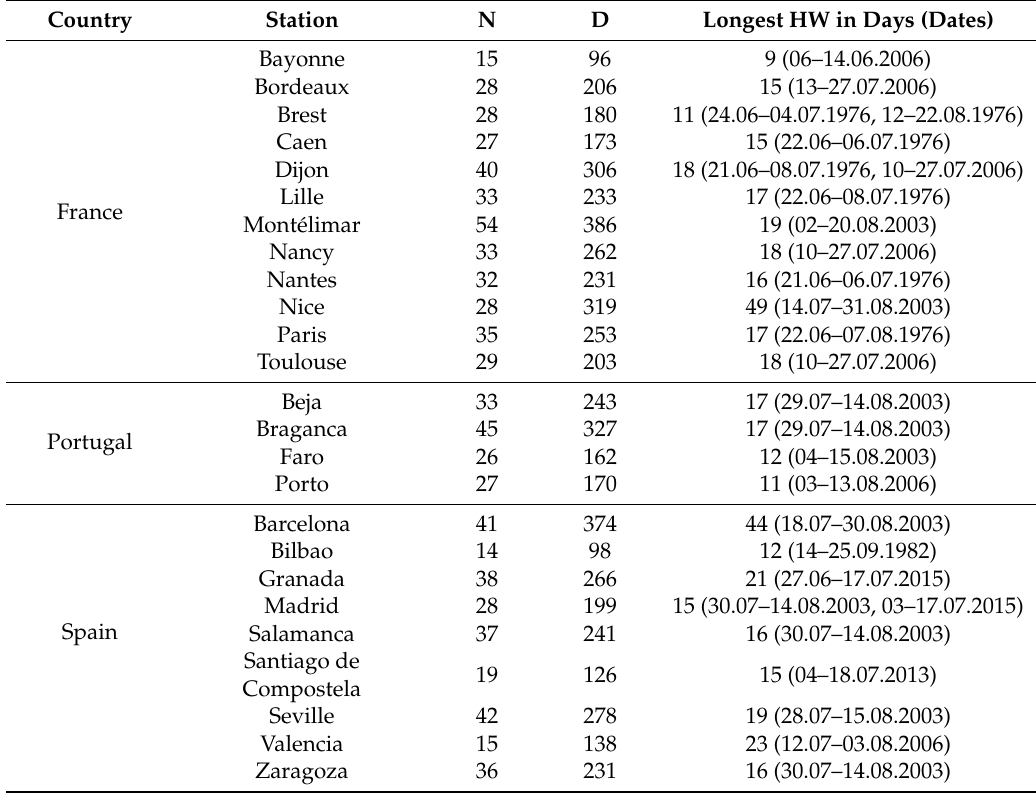
Table 1. Summary descriptive information on occurrence of HWs in 1976–2015. N—number of HWs; D—total duration of HWs; duration and date of the longest HW. Country Station N D Longest HW in Days